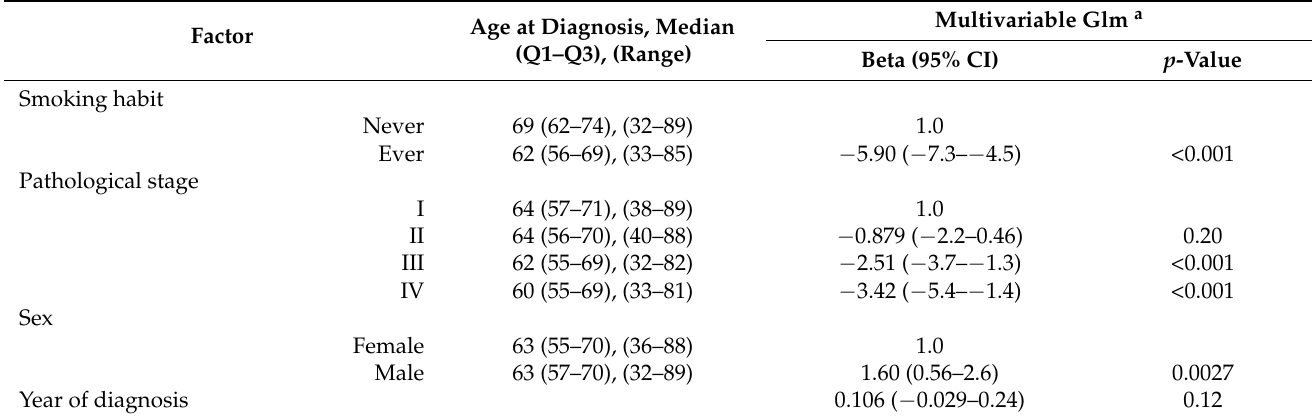
Table 4. Validation series: association of age at diagnosis of lung adenocarcinoma with smoking habit, pathological stage and sex, in 1384